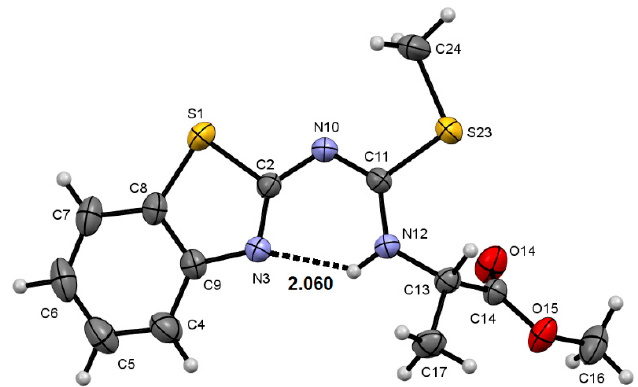
Figure 5. X-ray diffraction structure of compound 8b . Bond Lengths (Å): S(1)–C(2) 1.7618(1), S(1)–C(8)